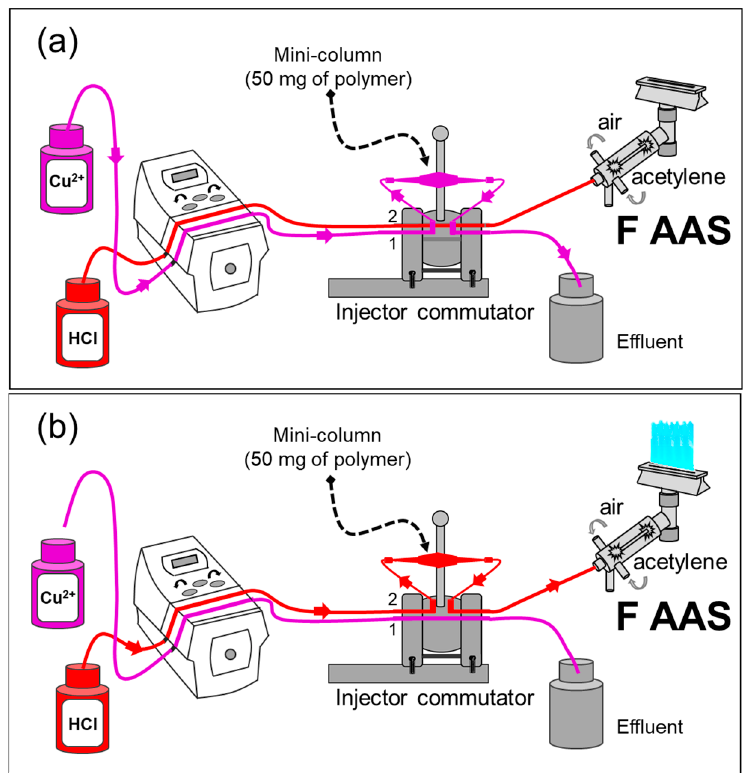
Figure 1. Scheme of the FIA-FAAS system: ( a ) preconcentration step—mini-column position in Line 1; ( b ) elution step—mini-column position in Line 2, using 0.40 mol L − 1 HCl. The flow rate for the preconcentration/elution was 14.0 mL min − 1 , and the sample volume was 30.0 mL. Adapted with permission from [36], copyright publisher,